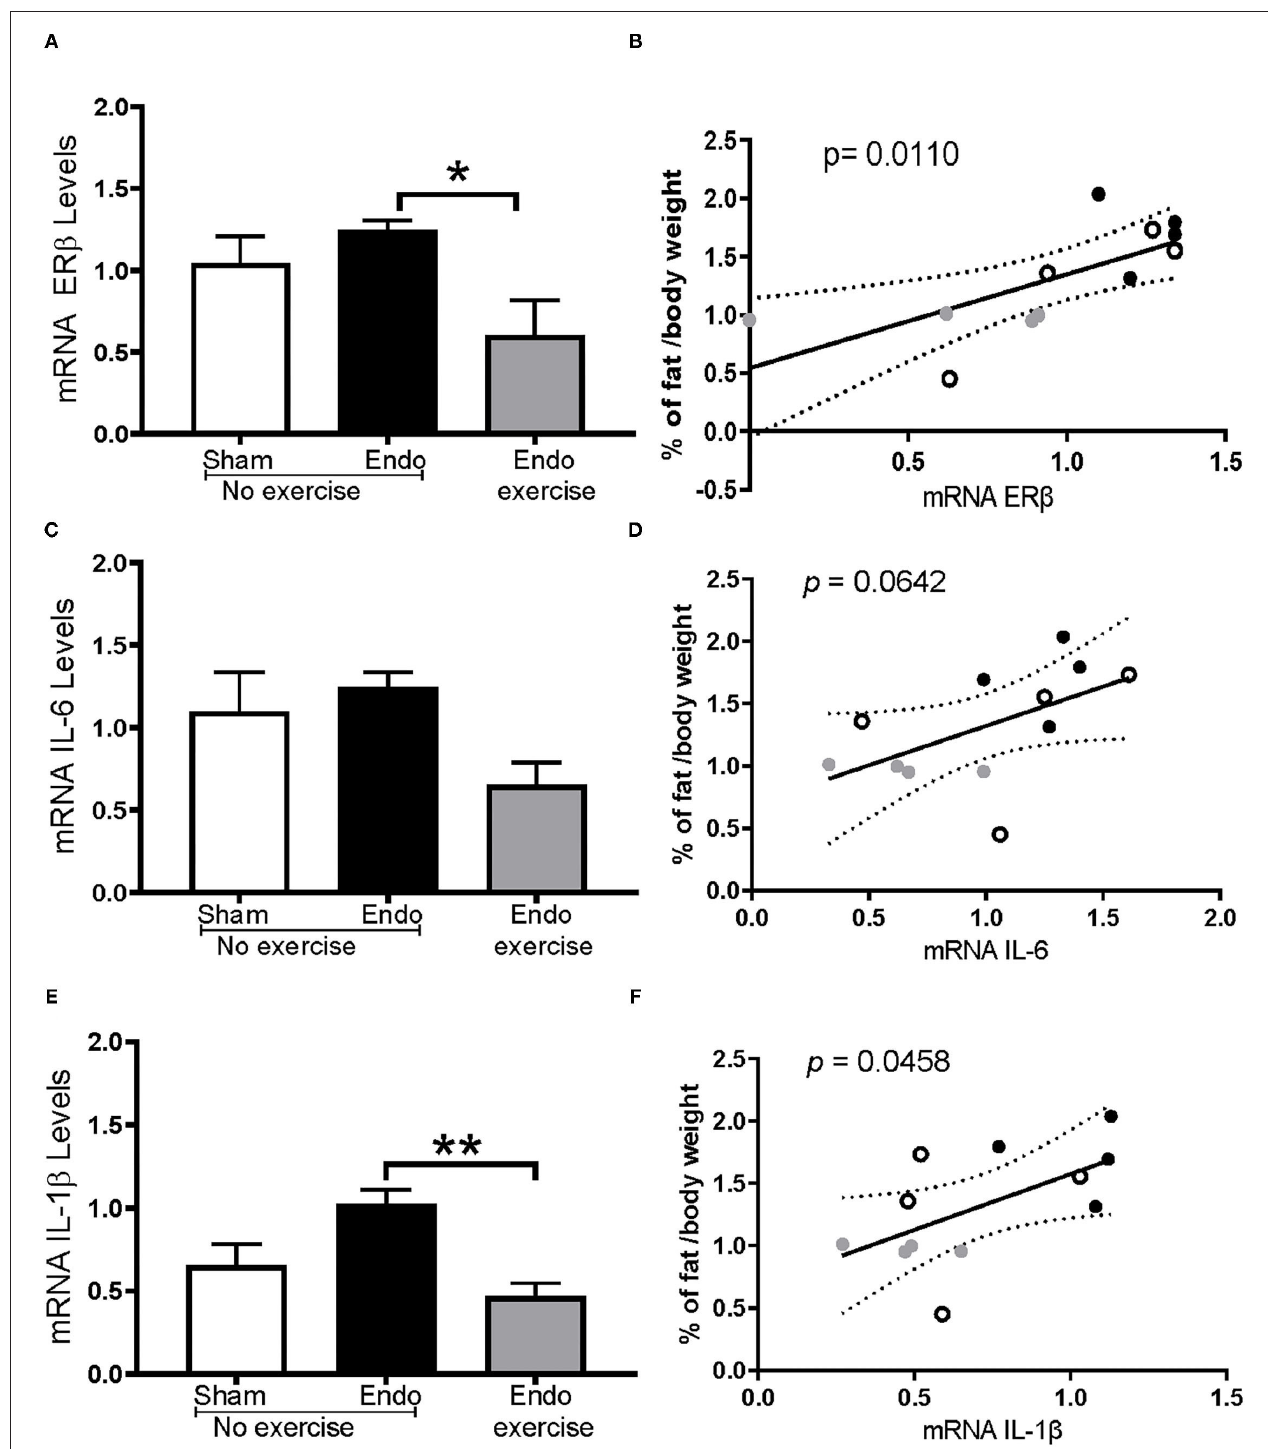
FIGURE 8 | Exercise impacts estrogen receptor beta and inflammatory cytokines in mesenteric fat. (A) mRNA ER β expression levels were significantly decreased in Endo-Exercise animals and (B) were significantly lower as the % of fat decreased. (C) Levels of IL-6 were mitigated by exercise and (D) these animals had a lower % of fat which correlated with a lower expression of IL-6 but didn’t reach significance ( p = 0.0642). (E) Endo-Exercise rats had a significantly lower expression of IL-1 β which also (F) correlated with lower % of mesenteric fat. ( n = 4/group ± sem; * p < 0.05, ** p < 0.01; white circles represent Sham-No exercise, black circles represent Endo-No exercise, gray circles represent